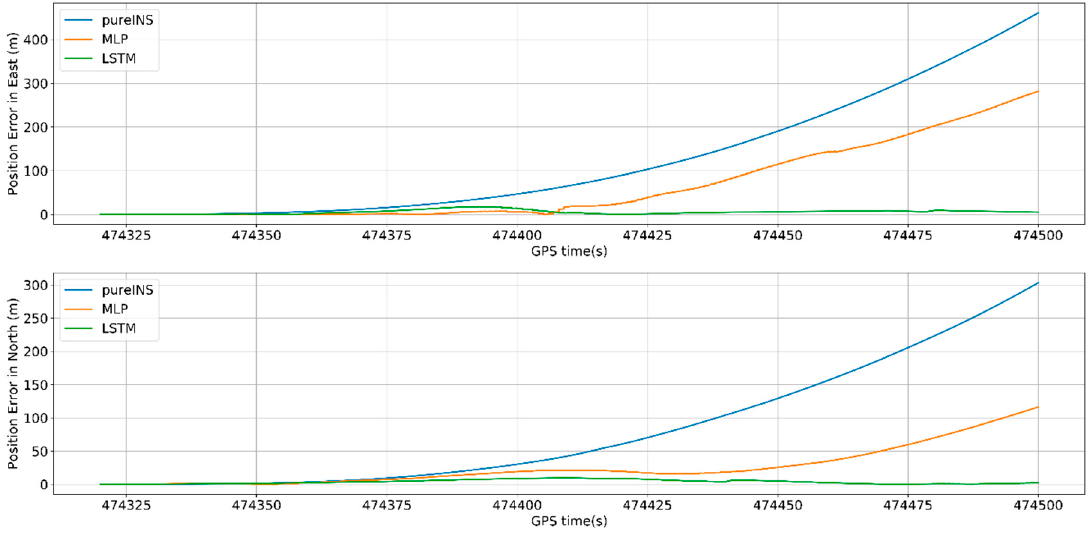
Figure 20. Position errors of 180 s outages with different algorithms.